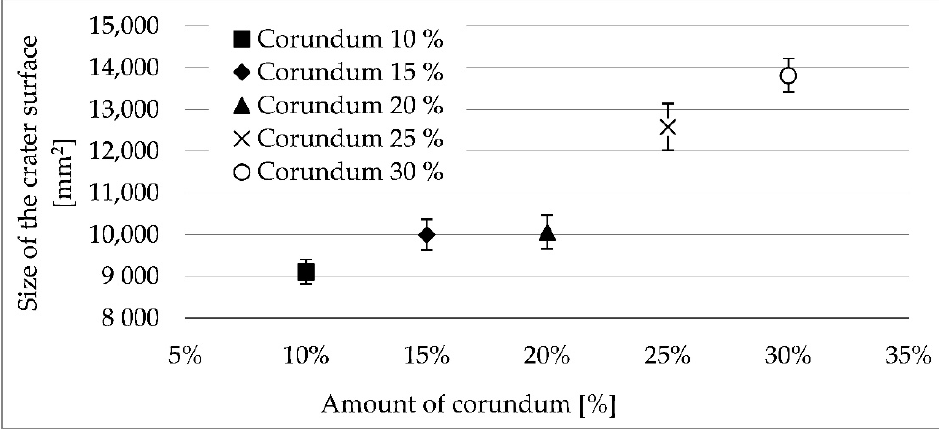
Figure 14. Rear side crater area by percentage substitution.